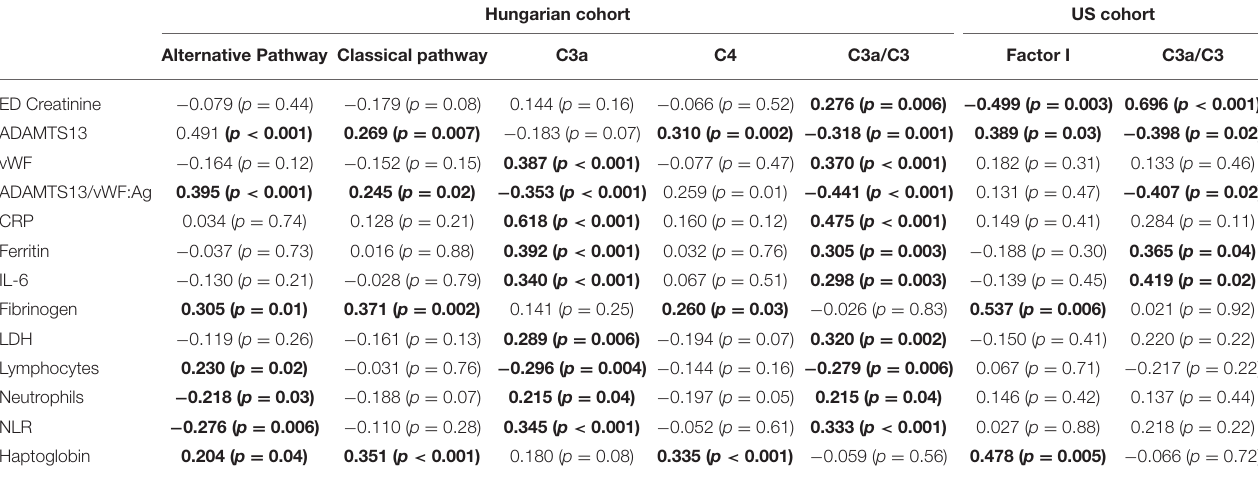
TABLE 5 | Spearman’s Correlation coefficients between complement parameters and other circulating biomarkers measured on admission. Hungarian cohort US cohort Alternative Pathway Classical pathway C3a C4